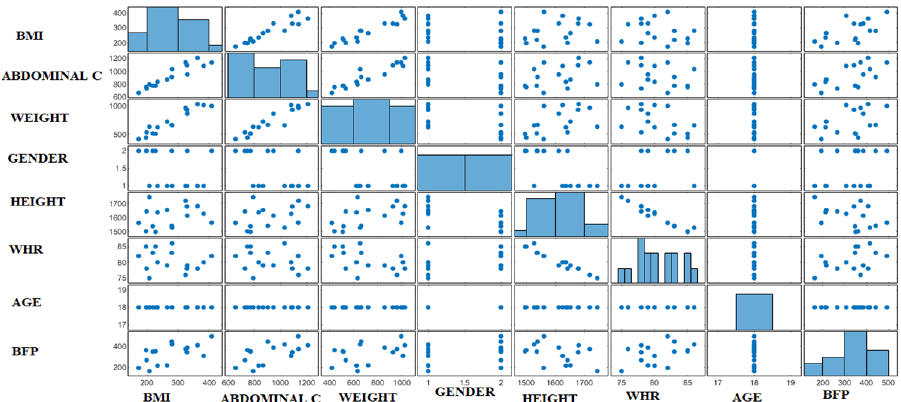
Figure 1. Plot of correlation matrix between the variables.